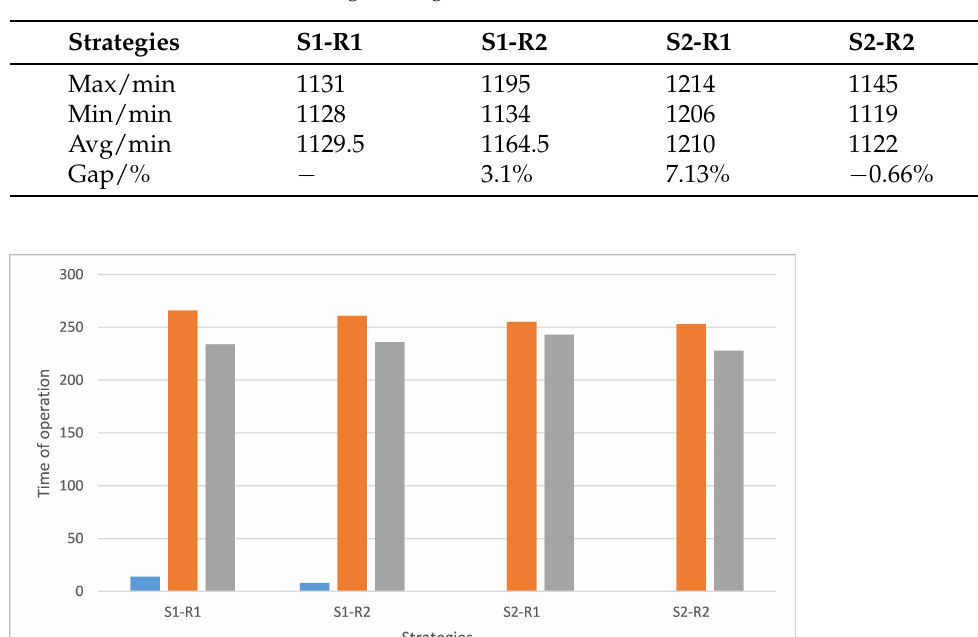
Table 5. Results of different stowage strategies.